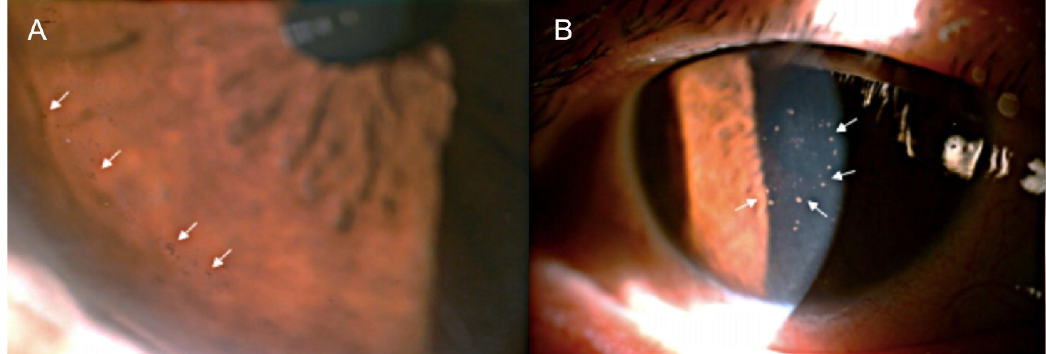
Figure 1. Clinical manifestations of cytomegalovirus anterior uveitis. ( A ) Pigmented keratic precipitates (KPs) (white arrows) in the peripheral cornea. ( B ) Typical coin-shaped KPs (white arrows) in the central cornea (Adapted from Kuo Yu-Wei, et al., Journal of Clinical Medicine, 2022 [30]).